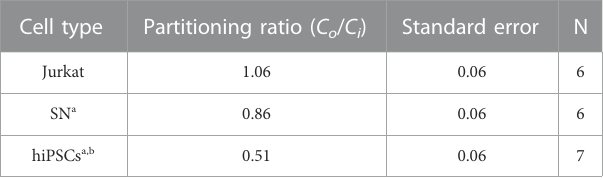
TABLE 3 Partitioning ratios of different cell types and standard error. Cell type